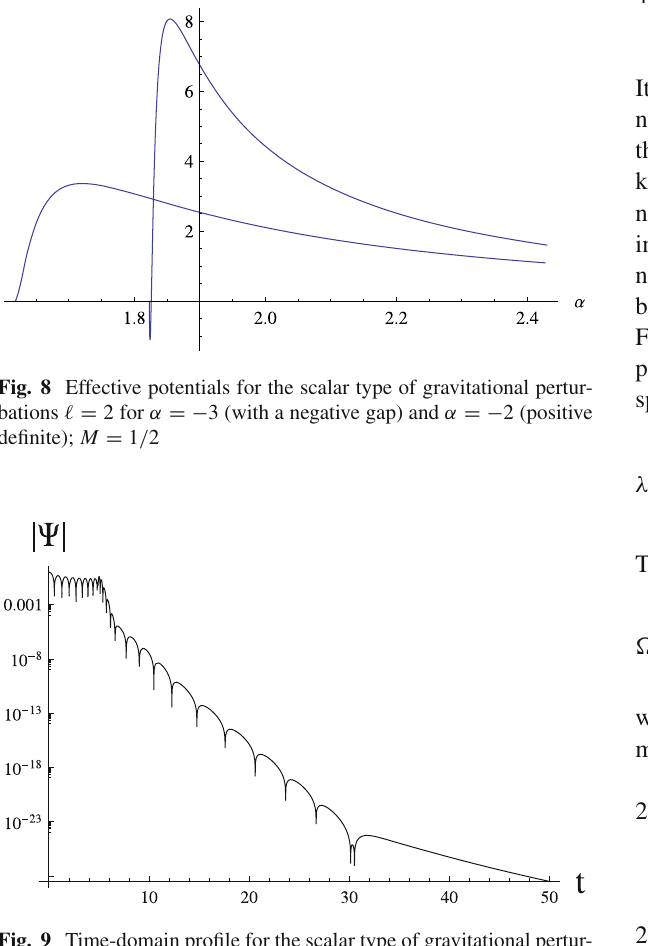
Fig. 9 Time-domain profile for the scalar type of gravitational pertur- bations, (cid:11) = 10, α = − 3 . 99. There are two concurrent modes, one of which dominates at the beginning of the quasinormal ringing ( ω = 8 . 25 − 6 . 12 i ) and the other one - at the final stage ( ω = 1 . 12 − 1 . 77 i ); M = 1 / 2. The initial outburst is prolonged because the spacial point at which the time-domain profile is taken is at some distance from the peak of the effective